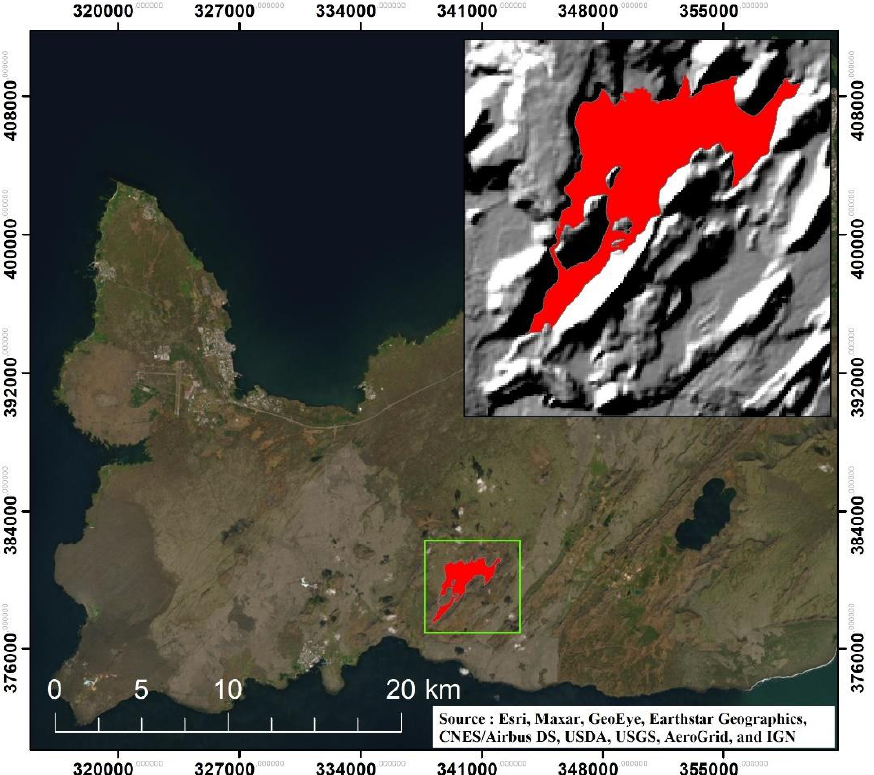
Figure 1. The 2021 Fagradalsfjall lava flow field map (red polygon). Green box indicates the image subset location. The shading in the image is the hill shade, created from ArcticDEM. The 2021 Fagradalsfjall lava flow field is situated at Mt. Fagradalsfjall Reykjanes Peninsula, Iceland. (Source of base map from Esri World Imagery [5]).